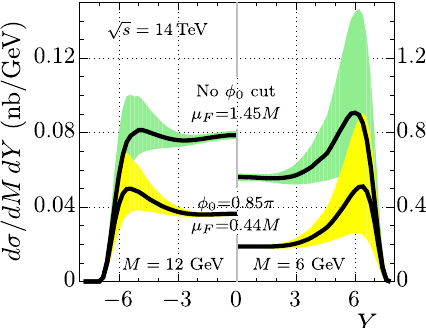
Fig. 4 Drell–Yan differential cross section for M = 12GeV (left) and 6GeV (right). The upper curves correspond to the result without any cut ( μ 0 = 1 . 45 M ) , while the lower ones, to the result with an azimuthal angle cutoff of φ 0 = 0 . 85 π . The bands display the 1 σ PDF uncertainty and show that they can be reduced by a proper measurement (with current LHC precision) of such observable